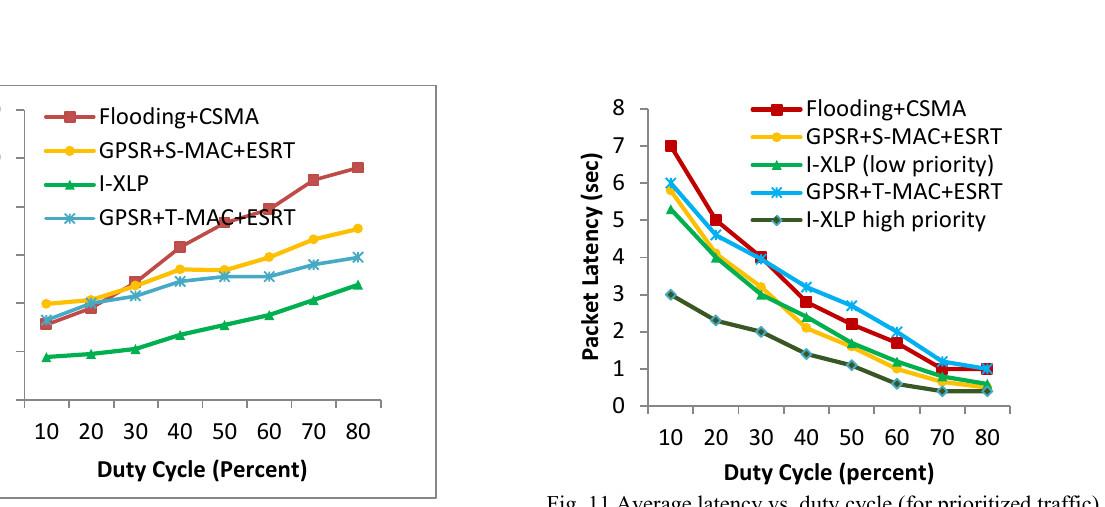
Fig. 8 Average energy consumption per bit vs. duty cycle (for non-prioritized traffic).]